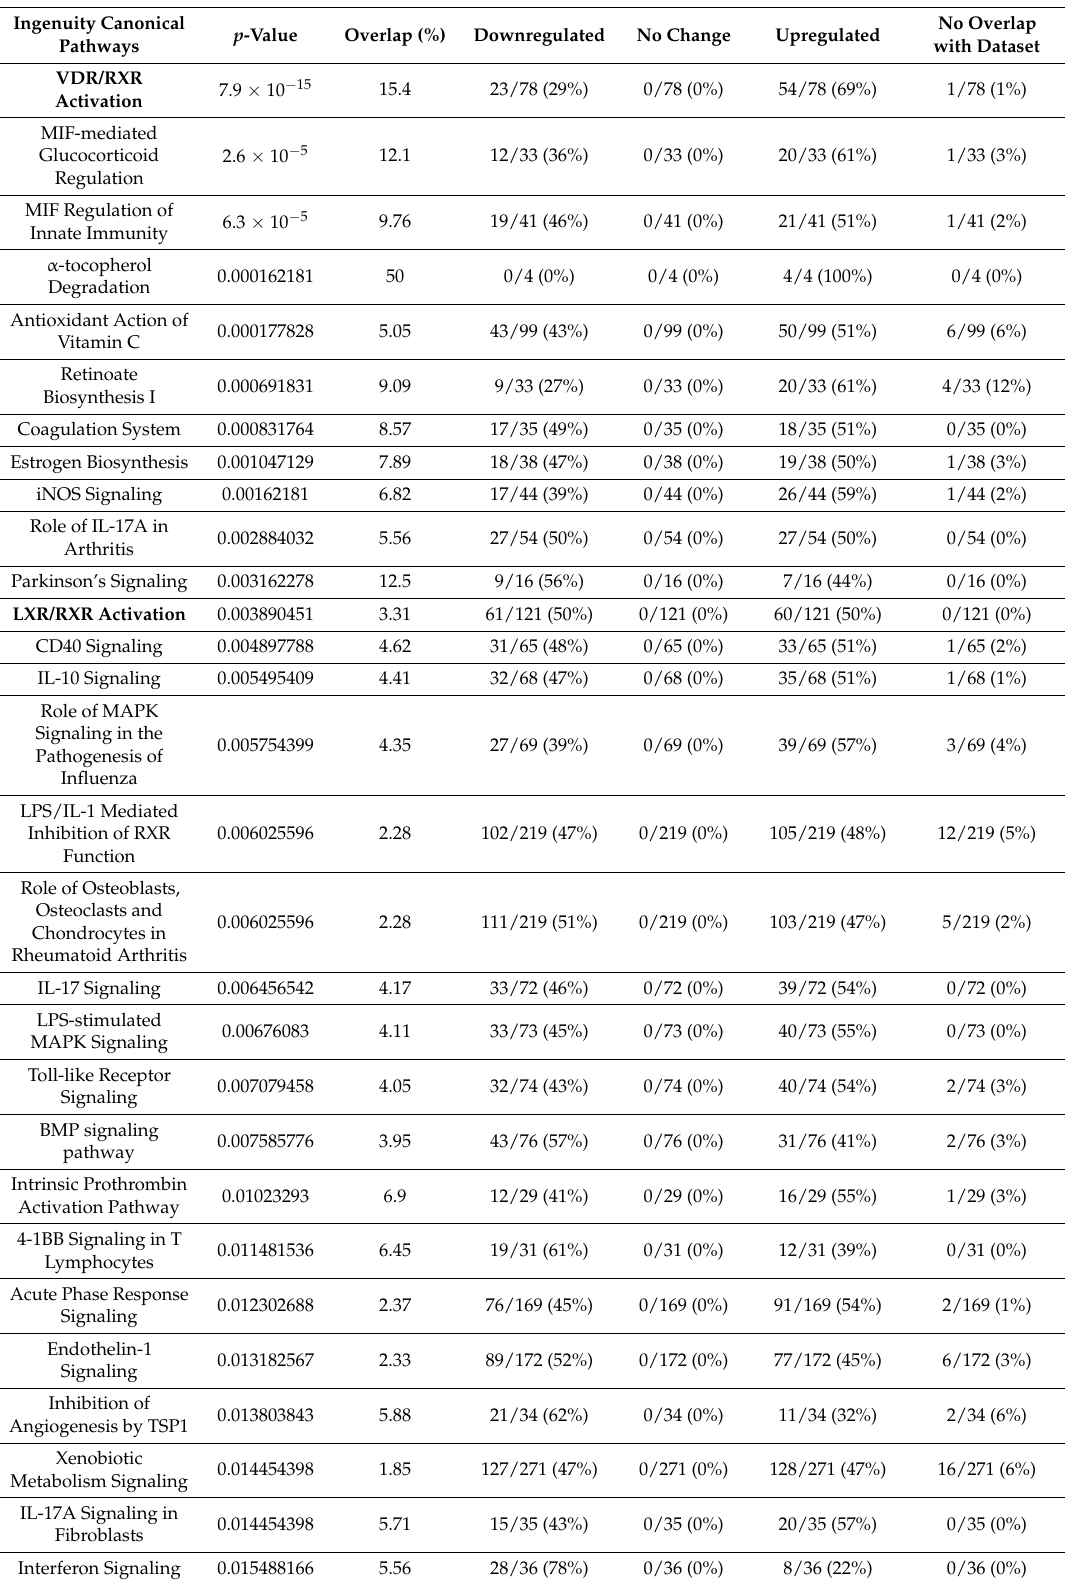
Table 8. Canonical pathways activated by 1,25(OH) 2 D3 in human epidermal keratinocytes after 24 h of treatment. Nuclear receptors are marked in